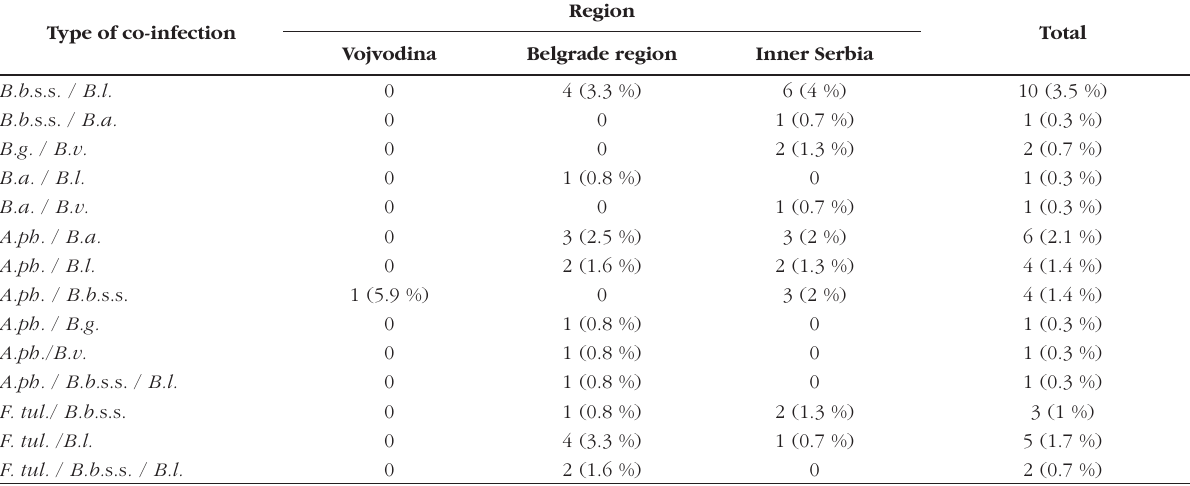
Table II. – Type and number of co-infections in adult I. ricinus ticks from Serbia.